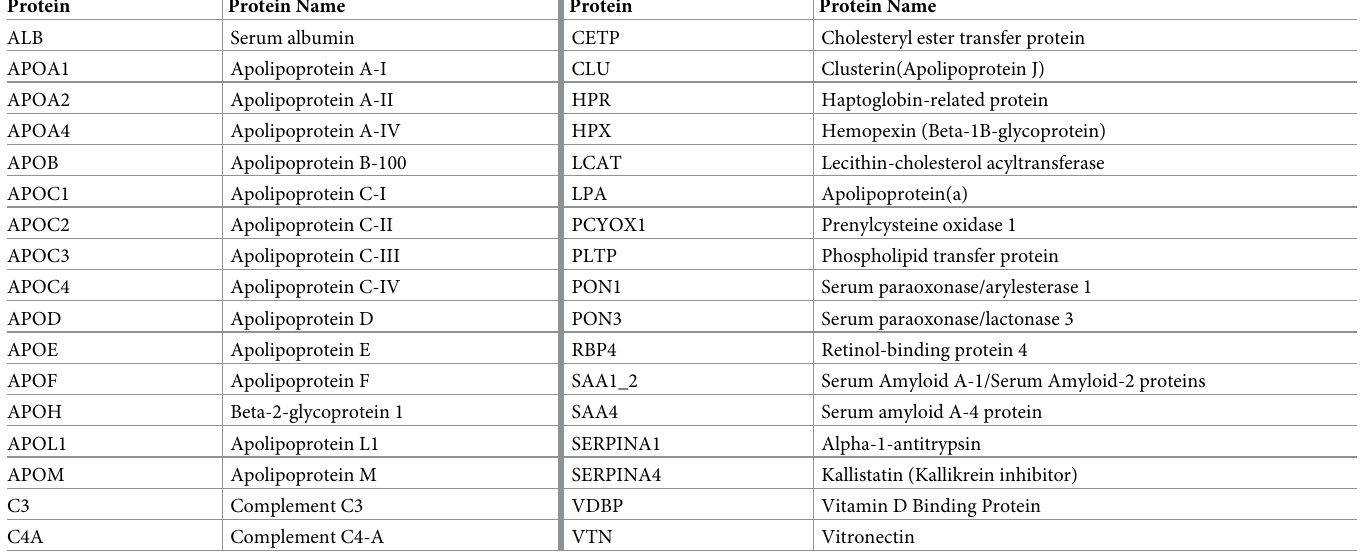
Table 3. Protein quantified in the targeted proteomics